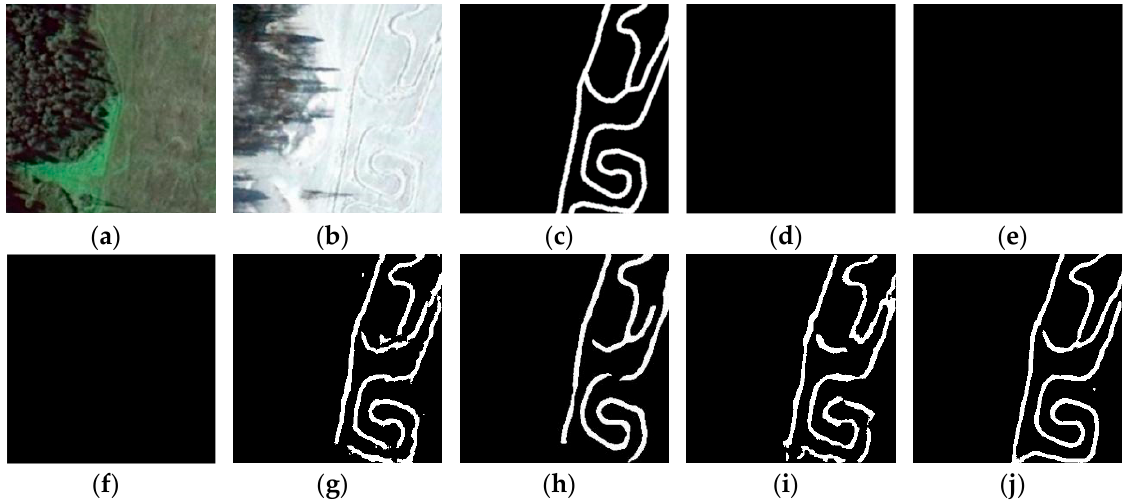
Figure 7. Visual comparison of change detection results in area 2: ( a ) T1 image, ( b ) T2 image, ( c ) ground truth, ( d ) FC-EF, ( e ) FC-Siam-conc, ( f ) FC-Siam-diff, ( g ) UNet++_MSOF, ( h ) IFN, ( i ) SNUNet-CD/32, ( j ) proposed method. The changed areas are marked by white, and the unchanged areas are marked by black.